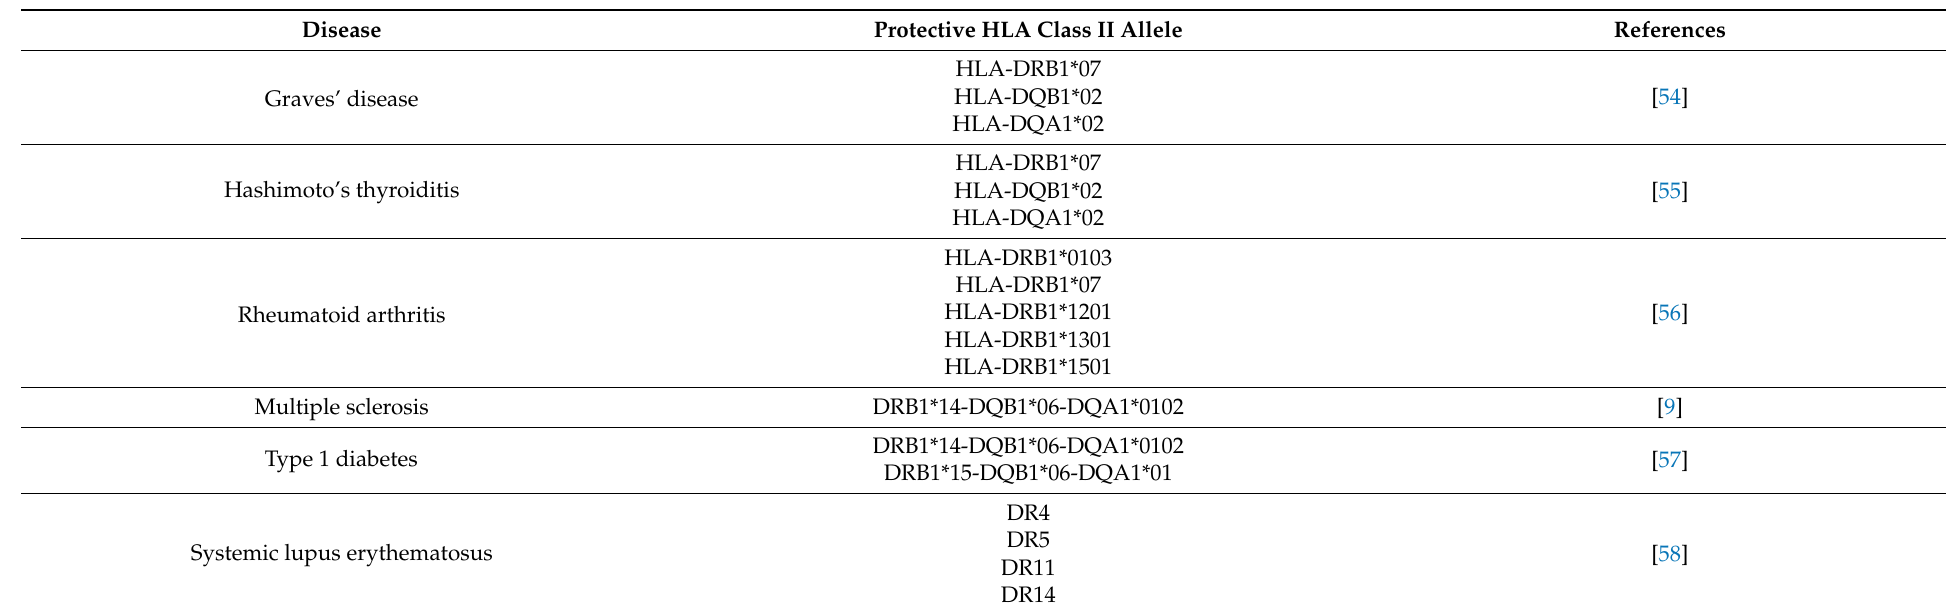
Table 2. Identifying protective HLA alleles in different autoimmune